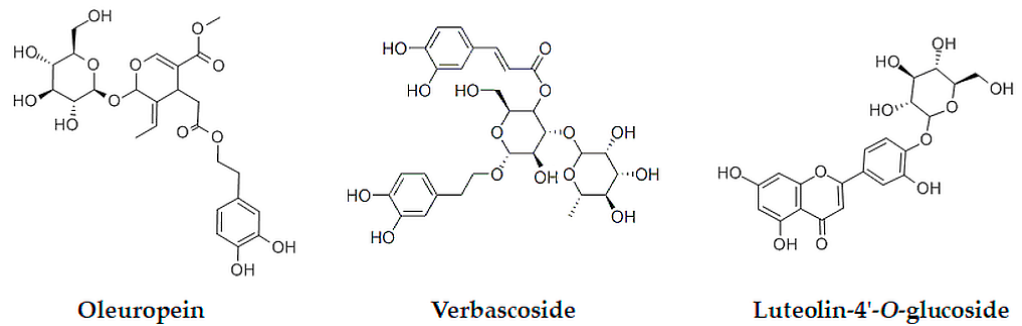
Figure 1. Structures of the most abundant phenolic compounds in olive leaves.